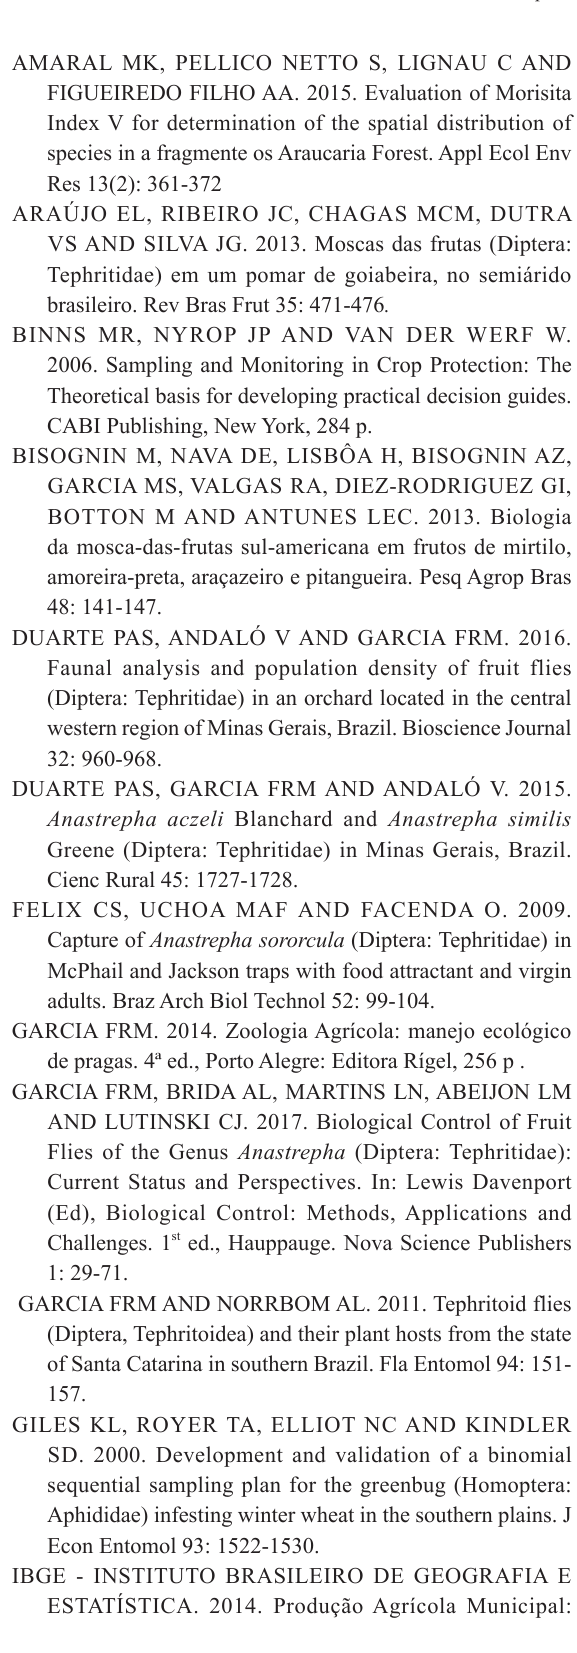
FIGUEIREDO FILHO AA. 2015. Evaluation of